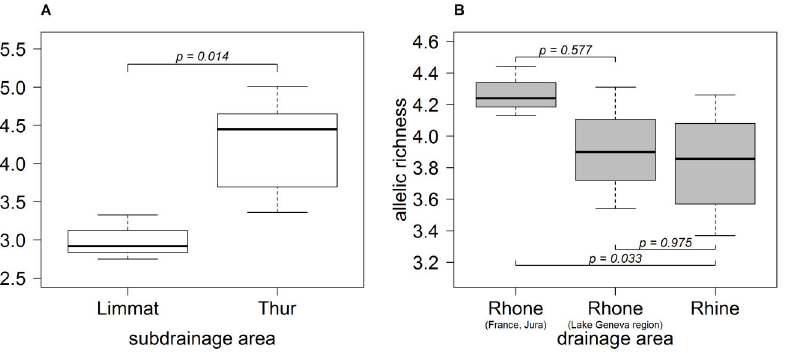
Figure 4. Allelic richness (average across loci) for different geographical groups of Gammarus fossarum . a) Difference between geographical groups of type A populations (Thur: east; Limmat: central). See Fig. 1 for location of subdrainages. The P-value (Mann-Whitney U test) is indicated. b) Difference among three geographical groups of type B populations. See Fig. 2 for location of geographical regions. ‘‘Rhone (France, Jura)’’ includes all Rhone populations except those in the Lake Geneva region. ‘‘Rhine’’ includes all Rhine type B populations except the genetically